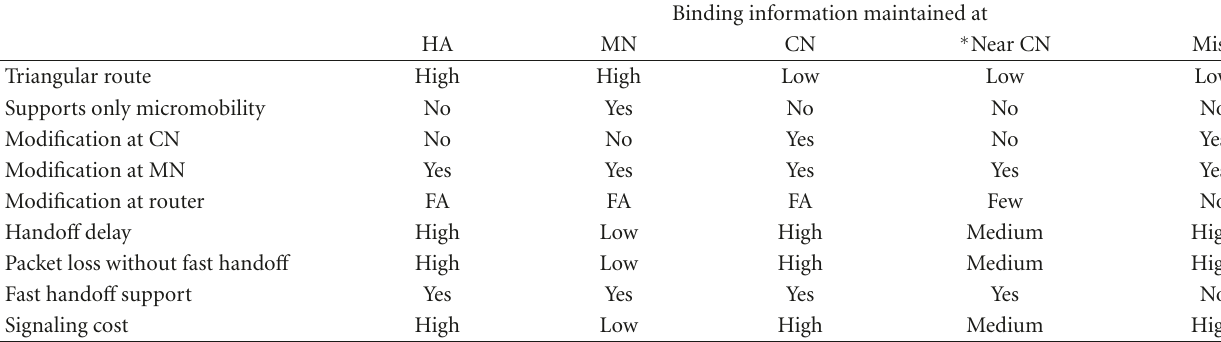
Table 1: Comparison between di ff erent classes.